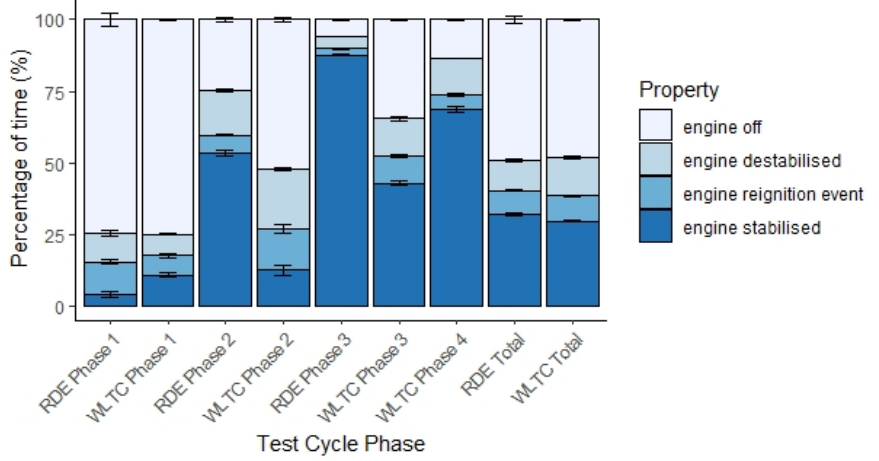
Figure 3. Percentage of time covered with the engine in different states of operation. Error bars represent the standard error of the repeats (two tests for each WLTC phase, three tests for each RDE phase).